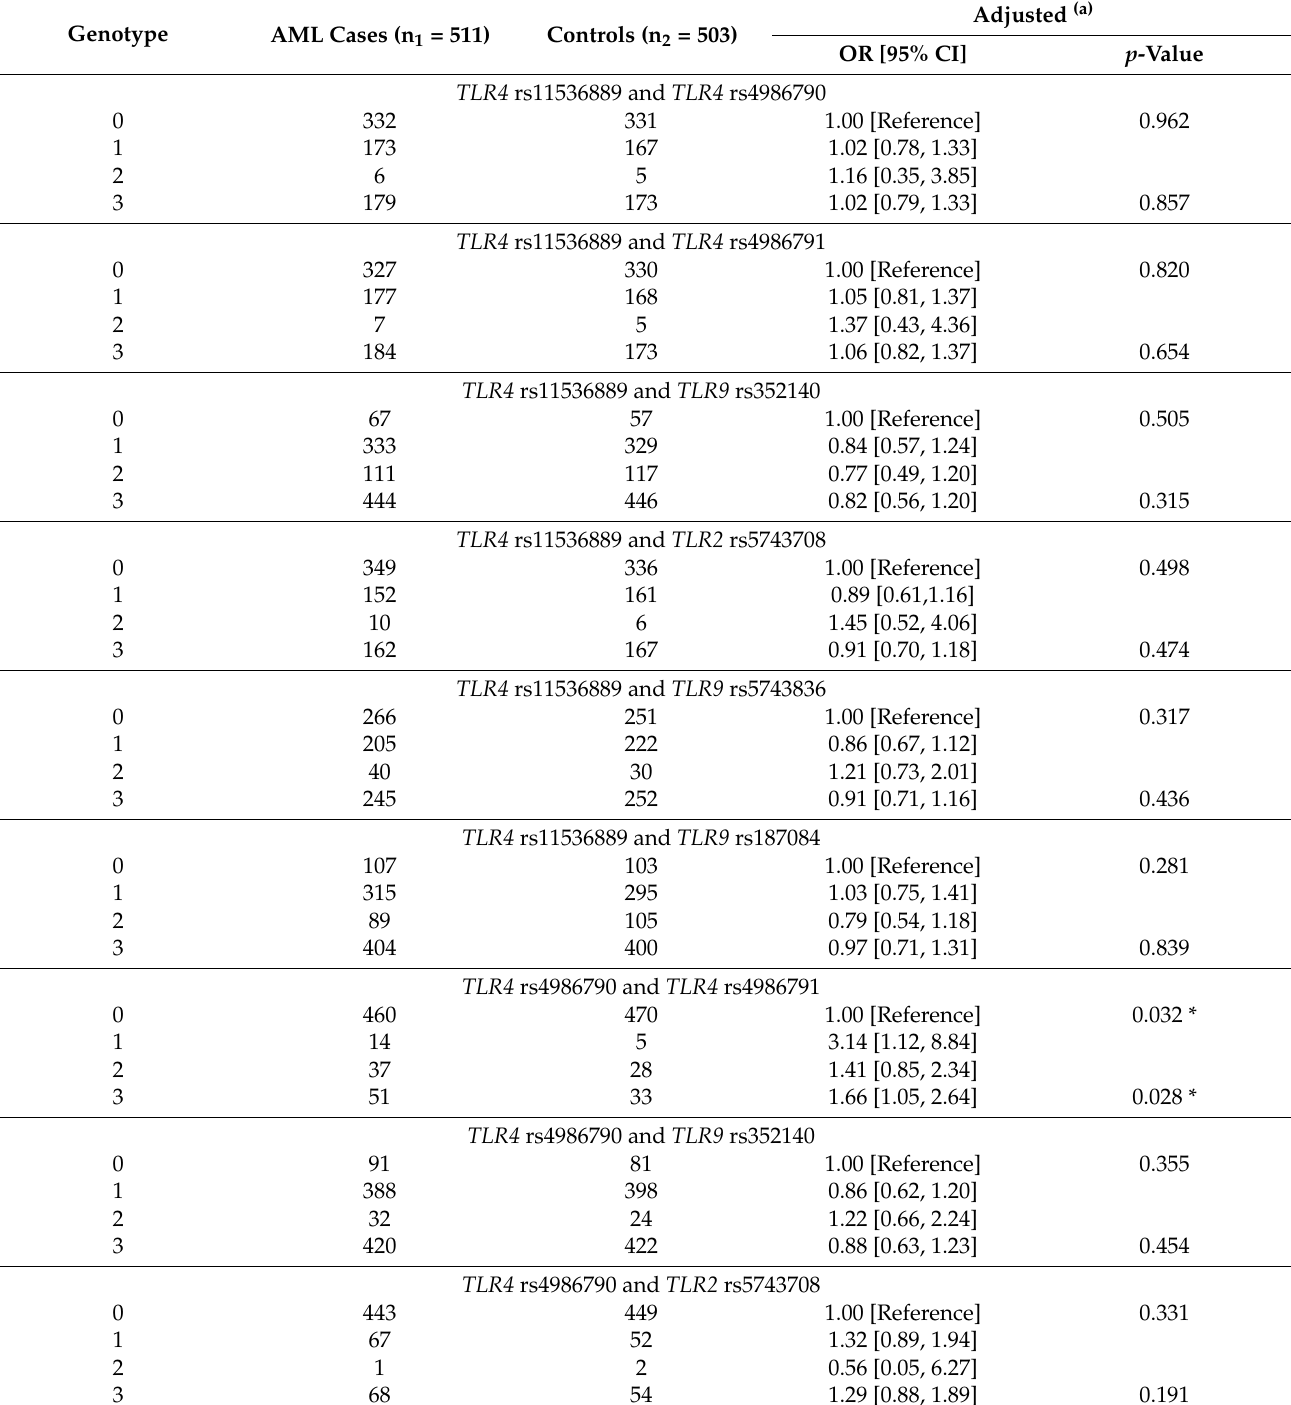
Table 5. Frequency distribution of genotypic pairwise combinations of TLR2 , TLR4 , and TLR9 SNPs and their association with AML